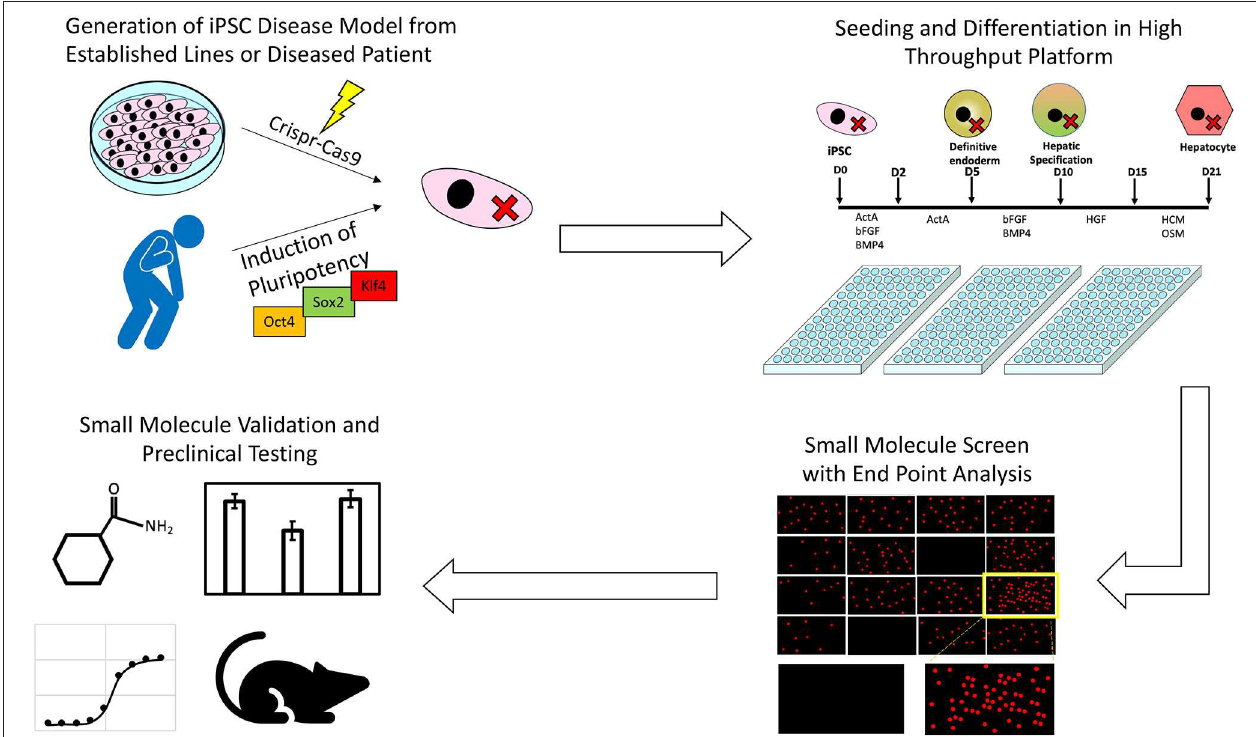
FIGURE 1 | An illustration of the process through which iPSCs along with high throughput screening platforms can be used to identify novel treatments for inborn errors in hepatic metabolism and other liver